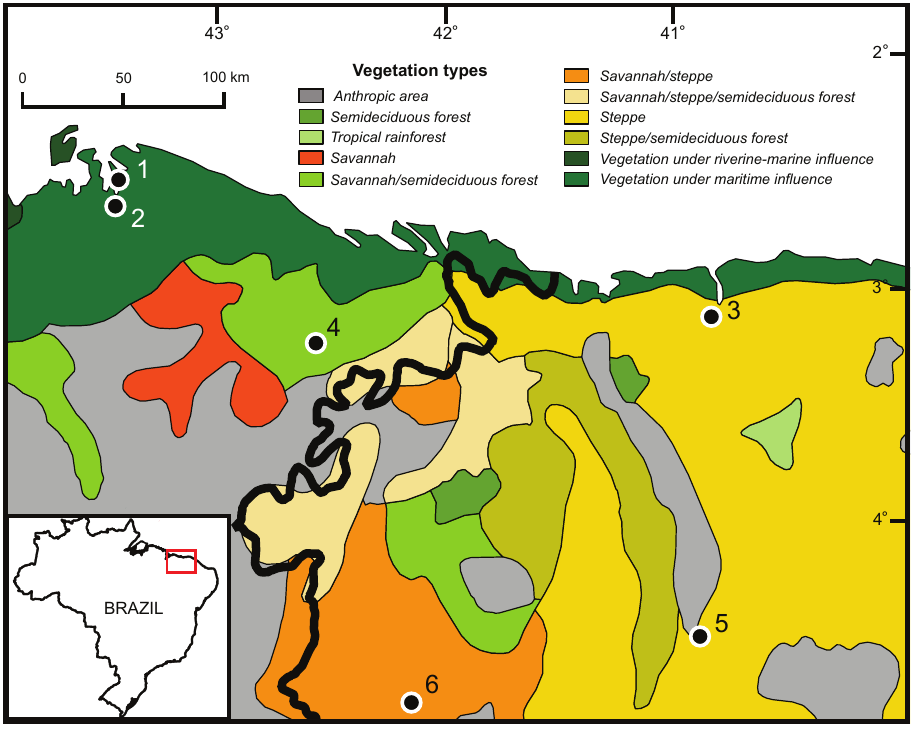
Figure 1. Localities of Alouatta belzebul ululata reported in the literature (Viana et al. 2015). Borders of biomes and habitat types as regarded by the Instituto Brasileiro de Geografia e Estatística (IBGE 2004a, b). Thick line represents the borders of the Cerrado (left) and the Caatinga (right) according to the IBGE (2004a). Localities: 1 Maranhão, Primeira Cruz (Igarapé das Palmeiras) (2.50°S, 43.33°W; Gregorin 2006) 2 Maranhão, Humberto de Campos (antiga Miritiba) (2.62°S, 43.45°W; Gregorin 2006) 3 Ceará, Granjá (Goiabeira) (3.10°S, 40.83°W; Gregorin 2006) 4 Maranhão, Boa Vista (3.22°S, 42.57°W; Gre- gorin 2006) 5 Ceará, São Benedito (Bom Jardim) (4.50°S, 40.88°W; Gregorin 2006); Piauí, Campo Maior [4.50°S, 40.88°W; description of locality from Viana et al. (2015); coordinates assigned by us and assessed via Google Earth version 7.1.7.2602]. Geographic coordinates in decimal degrees rounded to the nearest tenth. The original names in Portuguese for the vegetation types as reported by the IBGE (2004b) and their corresponding translation into English are as follows: área antropizada (anthropic area); floresta estacional semidecidual (semideciduous forest or dry forest); floresta ombrófila aberta (tropical rainforest); savana (savannah); savana/floresta estacional (savannah/semideciduous forest); savana/savana estépica (sa- vannah/steppe); savana/savana estépica/floresta estacional (savannah/steppe/semideciduous forest); savana estépica (steppe); savana estépica/floresta estacional (steppe/semideciduous forest); vegetação com influência fluviomarinha (vegetation under riverine-marine influence); vegetação com influência marinha (vegetation under maritime